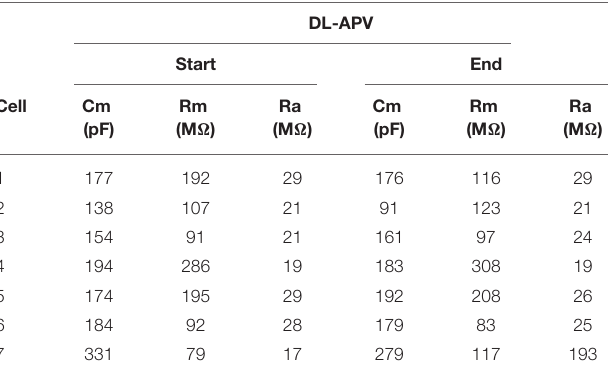
TABLE 6 | Membrane properties for experiment shown in Figure 7